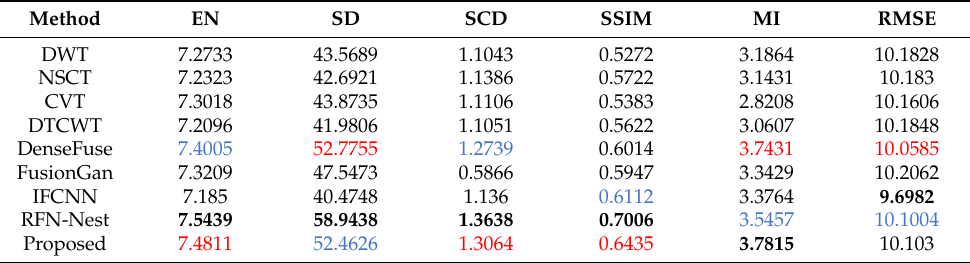
Figure 8. Subjective comparison between the proposed method and other state-of-art methods on 6 pairs of images from FLIR and LLVIP datasets. The first three pairs of images are selected from the FLIR dataset, and the last three pairs of images are selected from LLVIP dataset. Table 5. Quantitative results on 50 pairs of images from FLIR dataset. The best values, the second-best values and the third-best values are indicated in bold, red and blue,